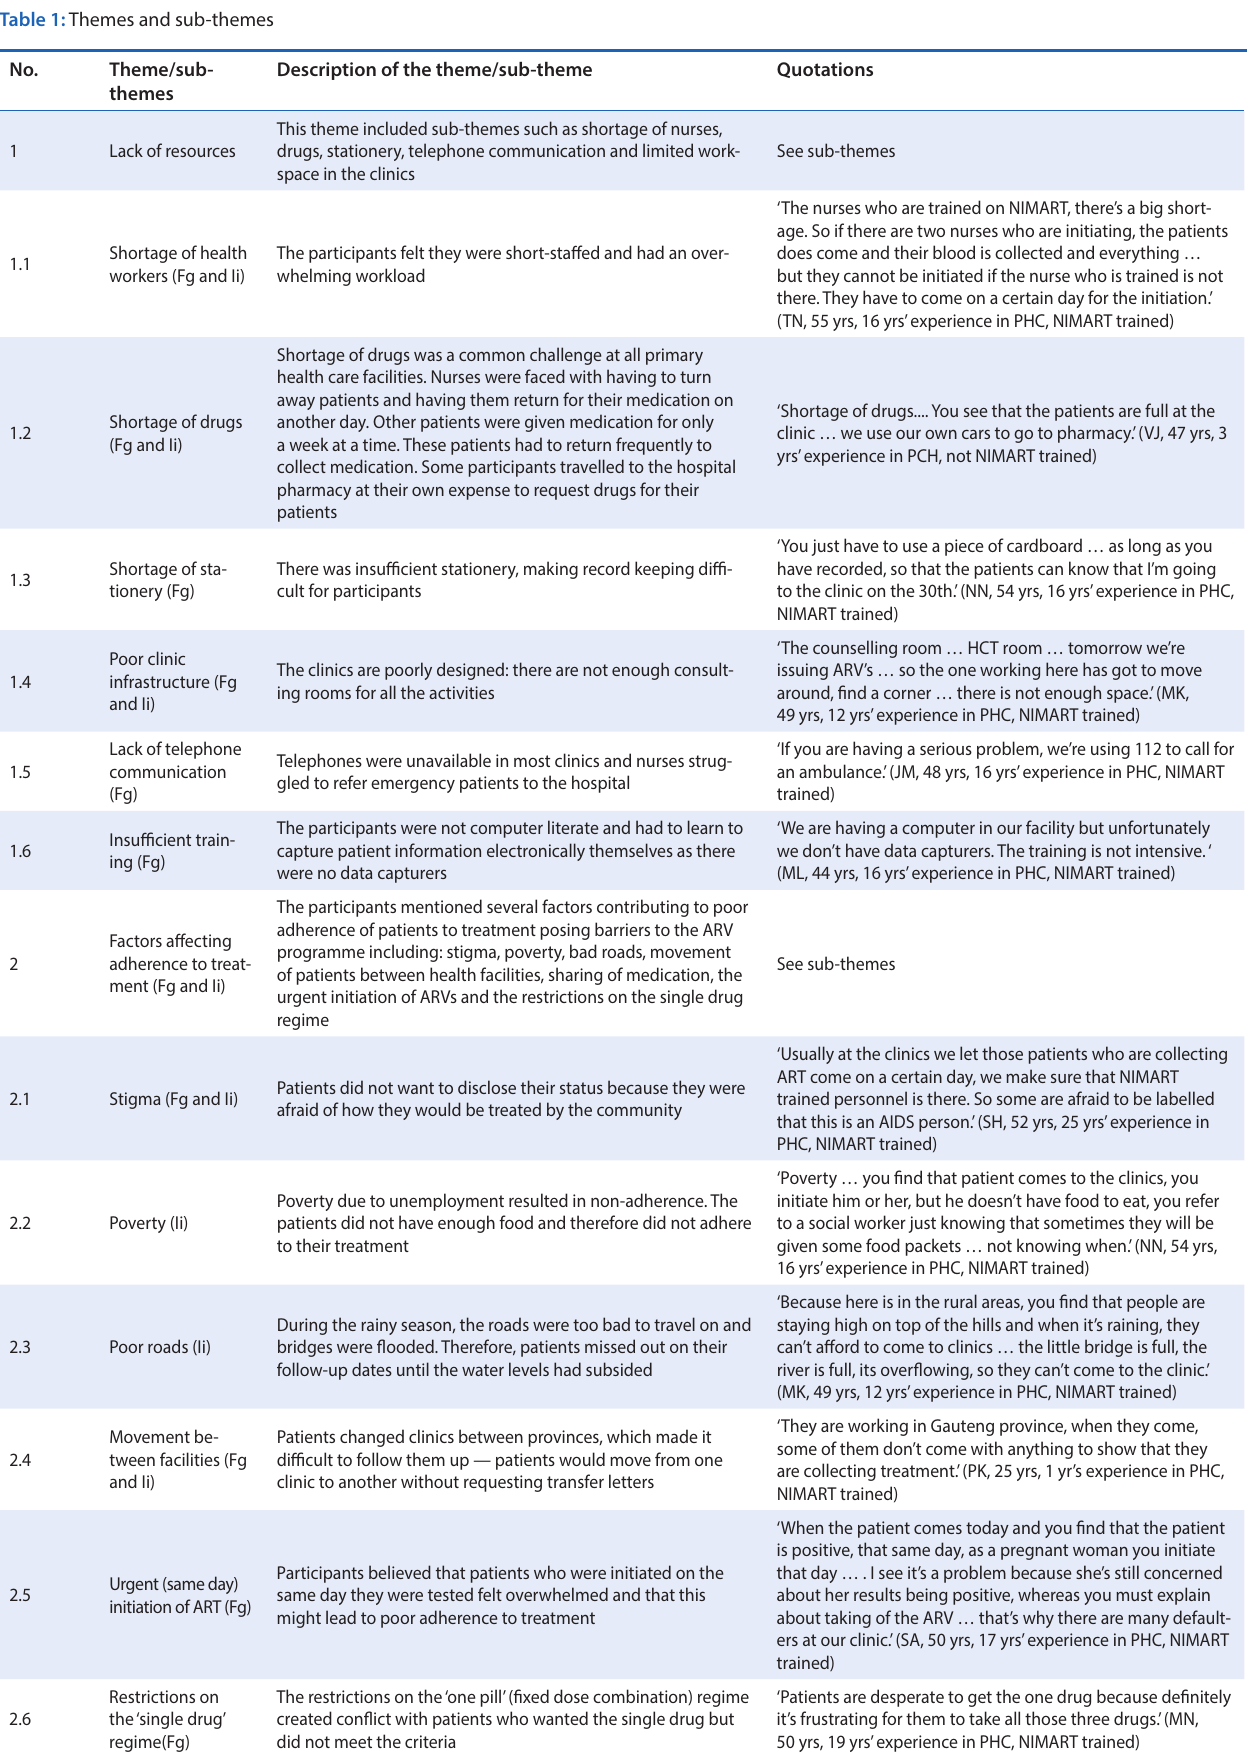
Table 1: Themes and sub-themes No. Theme/sub- Description of the theme/sub-theme themes